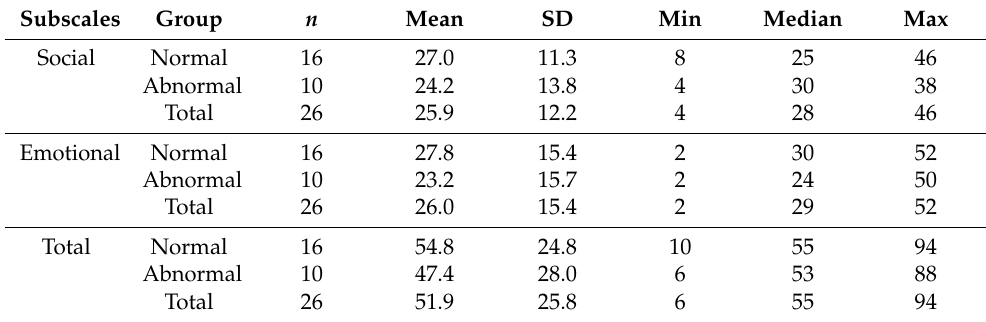
Table 5. Descriptive statistics for the scores on the subscales and overall HHIA value in the Normal and Abnormal